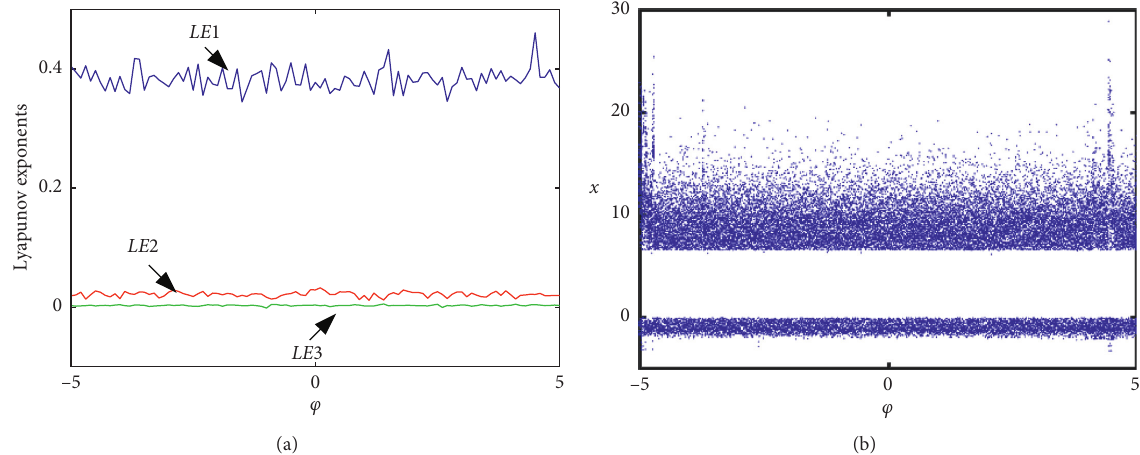
Figure 10: Lyapunov exponent spectra and bifurcation diagram of system (4) with a � 2, b � 3, c � 5, d � 0.75, and k � 1, while φ varies in [ − 5, 5]: (a) Lyapunov exponent spectra: LE 1 is blue, LE 2 is red, and LE 3 is green; (b) bifurcation